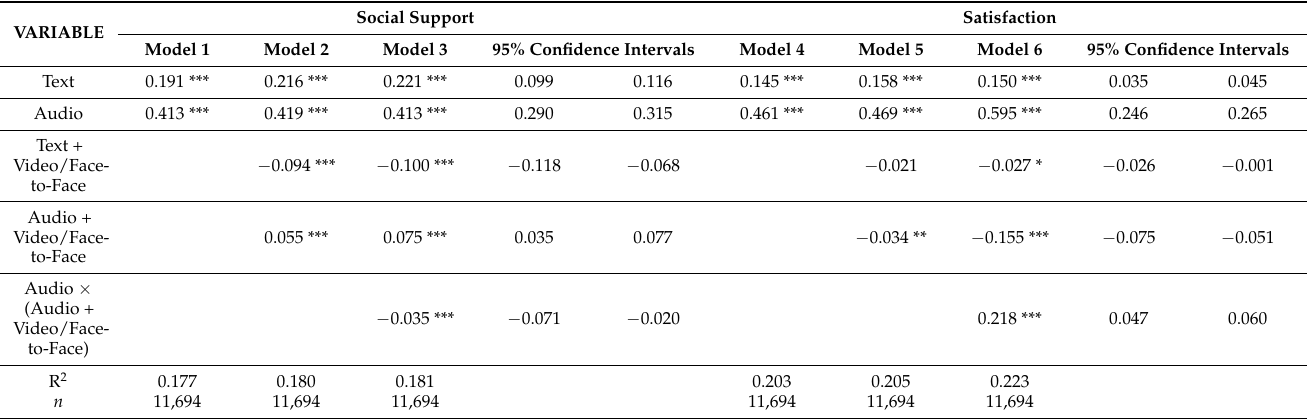
Table 12. Regression result—perceived social support and satisfaction.